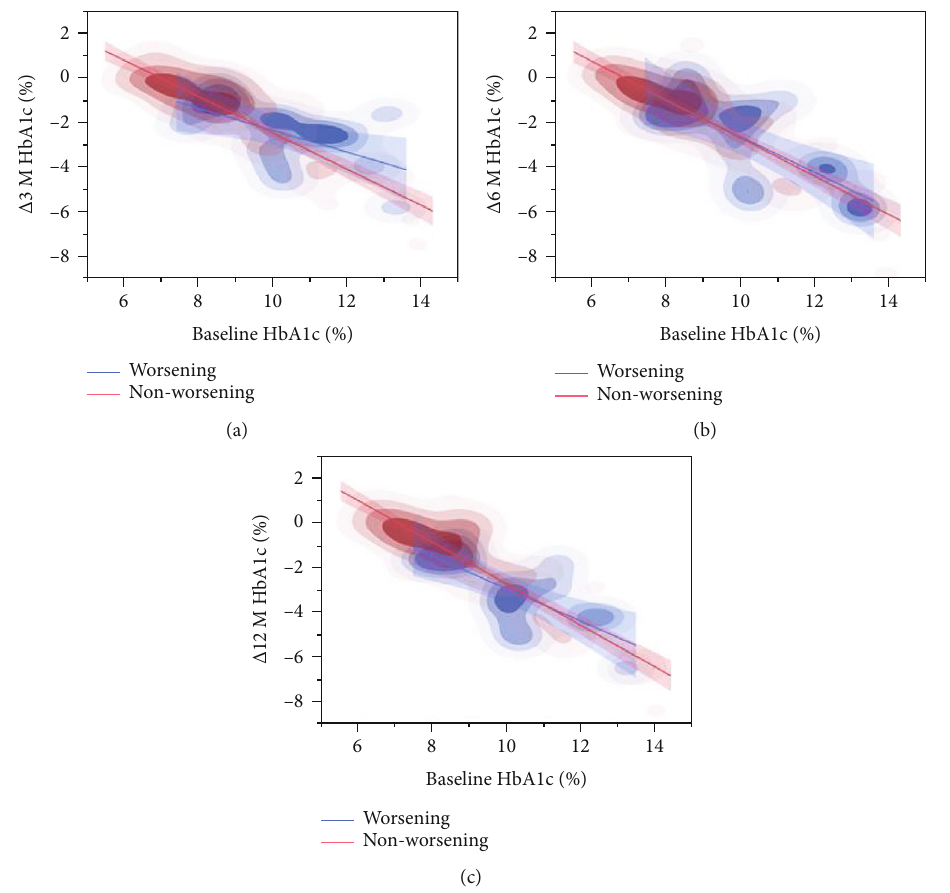
Figure 2: Two-dimensional density plots and regression line of baseline HbA1c and Δ HbA1c comparing the retinopathy worsening (blue) and nonworsening (red) groups in patients with simple diabetic retinopathy (SDR). The X -axis represents baseline HbA1c level, whereas the Y -axis represents Δ 3M HbA1c (a), Δ 6 M HbA1c (b), or Δ 12M HbA1c (c). High baseline HbA1c was associated with lower levels of Δ 3M HbA1c, Δ 6M HbA1c, and Δ 12M HbA1c. The worsening group had greater baseline HbA1c distribution at the high region and greater Δ 3 M HbA1c, Δ 6M HbA1c, and Δ 12 MHbA1c distribution at the low region compared to the nonworsening